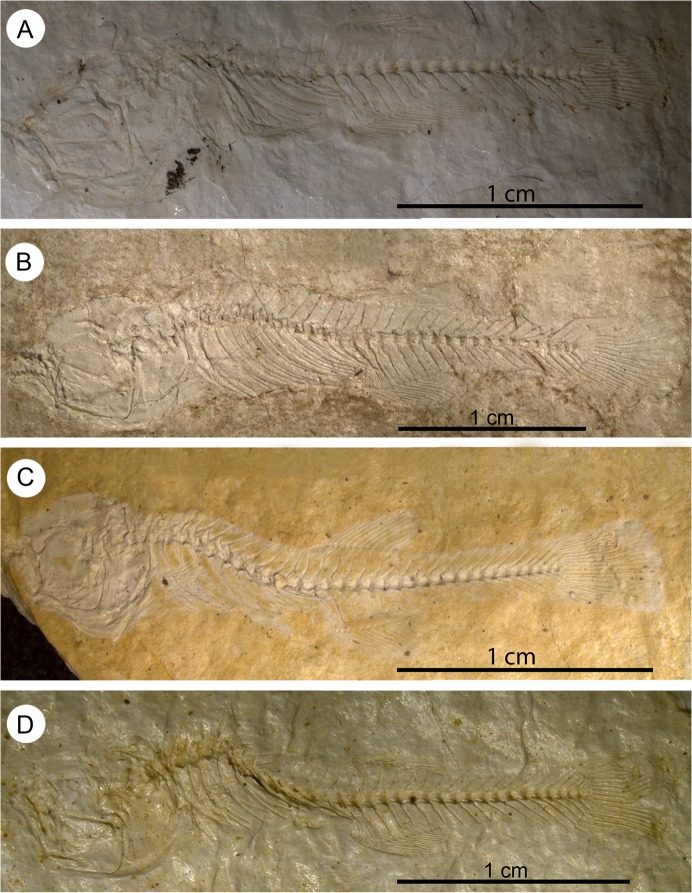
General view of four specimens of †K. kipkechi sp. nov. showing the varying extent of curvature of the vertebral column.
A, straight (paratype 1146´04, mirrored); B, almost straight (paratype 1228(1)´04, mirrored); C, strongly curved (paratype 1168´04); D, strongly curved (paratype 1206(1)´04).